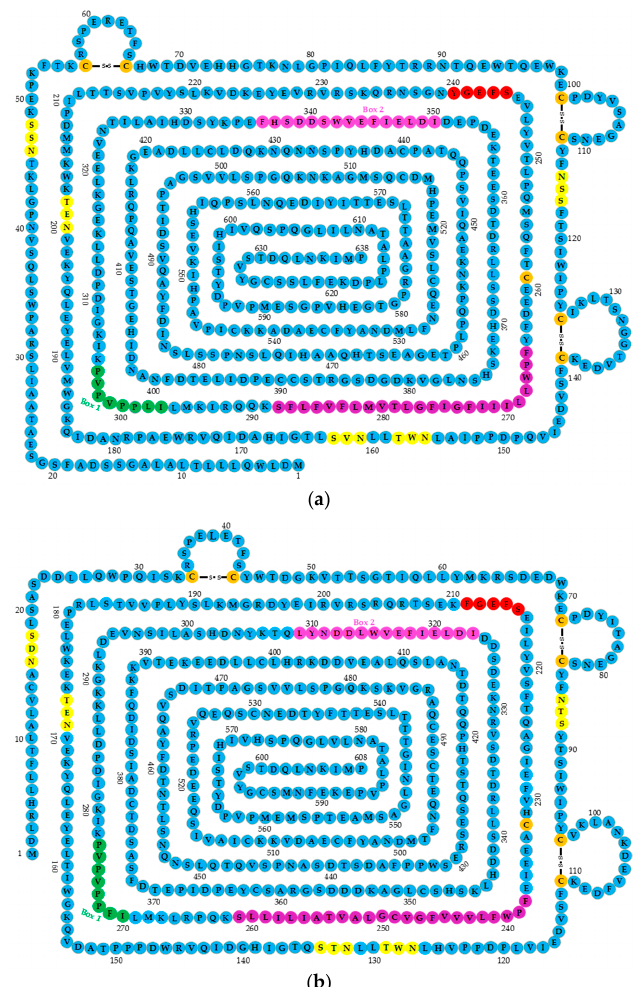
Figure 1. The structures of human and chicken growth hormone receptor genes ( GHRs ). ( a ) The structure of human GHR ; ( b ) the structure of chicken GHR . The extracellular domain (ECD) contains five conserved glycosylation sites (yellow) (NXS/T, where X represents any amino acid), 7.5 cystine residues (orange), six of which are linked by disulfide bonds, and a WSXWS motif (240 – 244, shown in red); a transmembrane domain (TMD) shown in purple; and an intracellular domain (ICD), where Box 1 is shown in dark green, and Box 2 in pink.